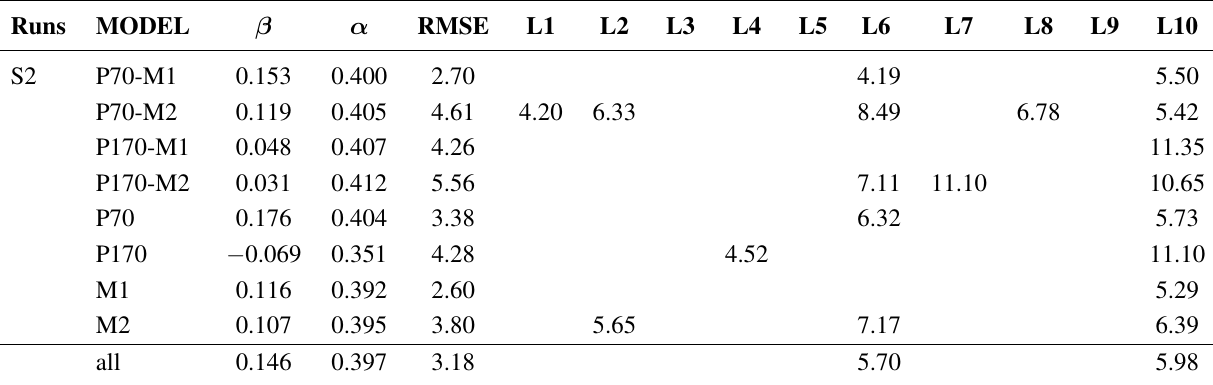
) calc ) are shown as well, together with errors exp deviates calc